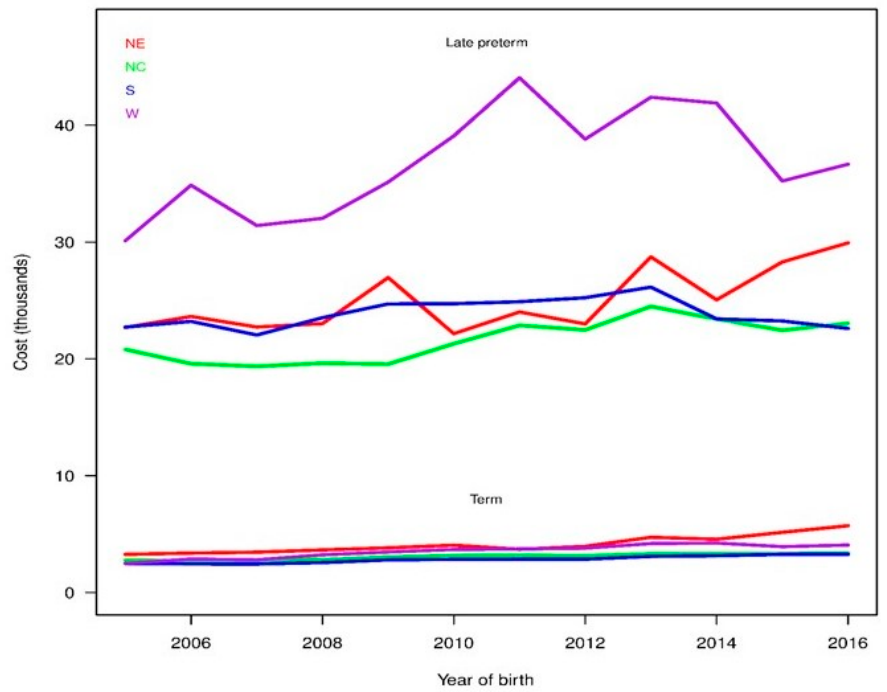
Figure 3. Birth hospitalization costs based on region. Estimated mean birth hospitalization costs for late preterm and term infants from regression models fitted separately for each region. The United States was divided in four representative regions (Northeast (NE), Northcentral (NC), South (S), and West